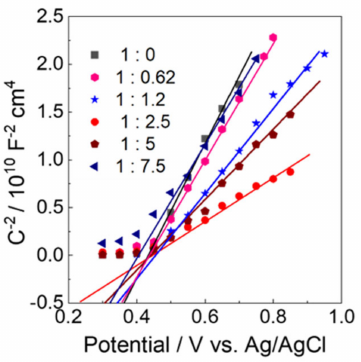
Figure 8. Mott-Schottky plots of (black) WO 3 − 0, (pink) WO 3 − 0.62, (blue) WO 3 − 1.2, (red) WO 3 − 2.5, (wine) WO 3 − 5, and (navy) WO 3 − 7.5 electrodes in a 0.1 M phosphate buffer solution of pH 6.0. frequency, 0.1 Hz; amplitude potential, 10